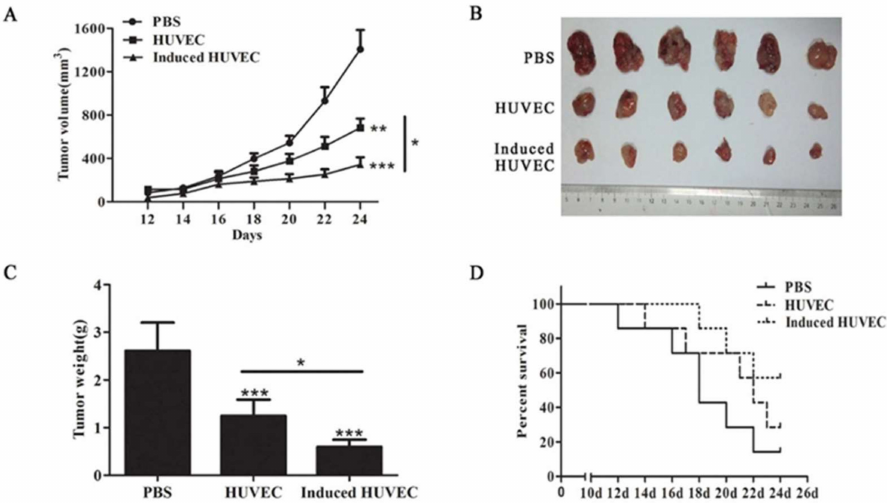
Figure 2. The TCM-induced HUVEC vaccine possessed better antitumor e ff ects than the HUVEC vaccine. ( A ) Tumor growth was measured every other day after day 12; ( B ) tumors of each group were photographed after being stripped from mice; ( C ) tumor weight was tested after removal from mice. ( D ) Survival data of each group was compared, (* p < 0.05; ** p < 0.01; *** p <